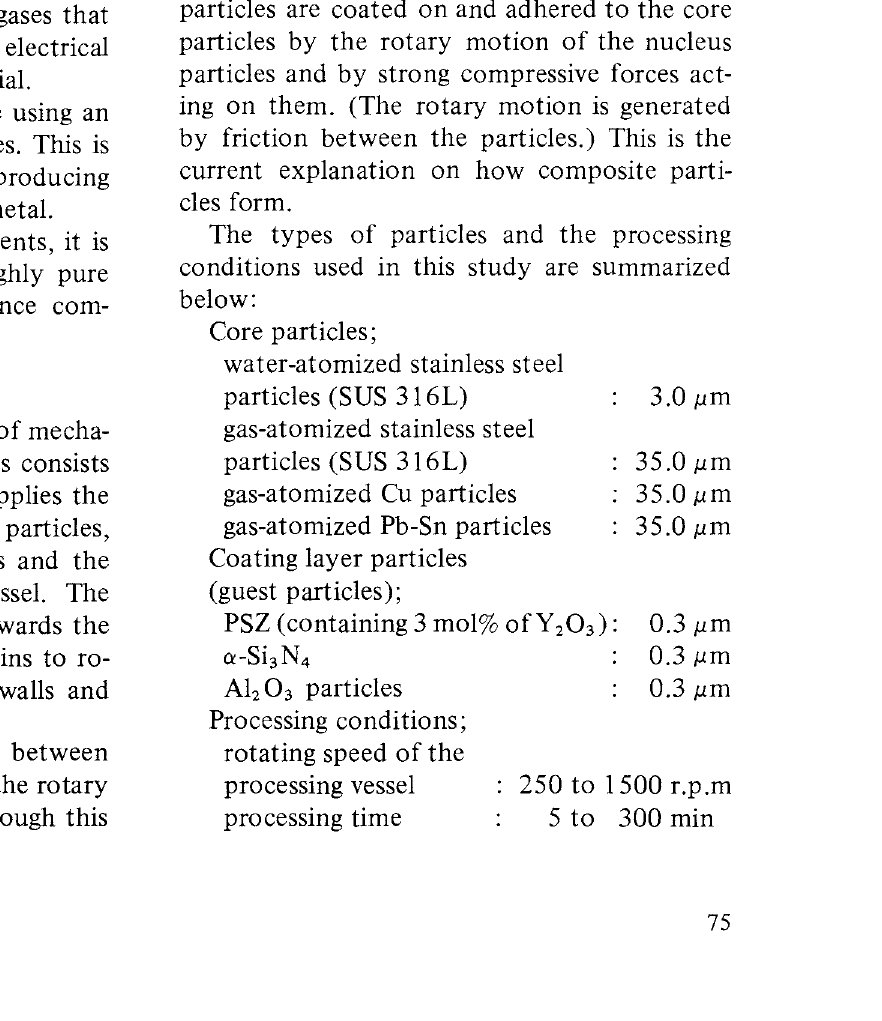
Fig. 1 Principles of